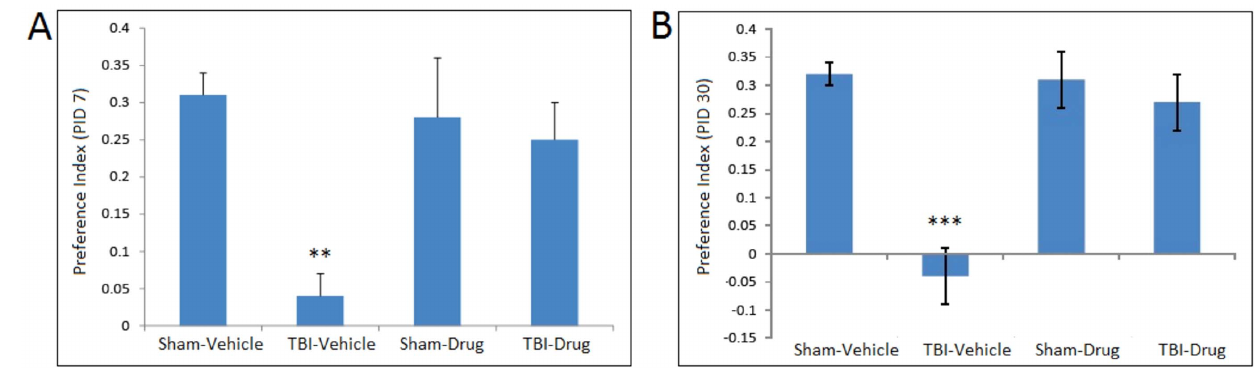
Figure 3. Novel Object Recognition. Preference index for the novel object in the Novel Object Recognition task across post-injury time points. Separate ANOVAs were used to compare the preference index for the novel object during the recall phase of the task. A) Weight drop injury resulted in significant object memory impairment on post-injury day (PID) 7 (A) and PID 30 (B) in injured vehicle-treated mice as compared to all other treatment groups. At both post-injury time points, post-TBI treatment with N-Acetylcysteine + topiramate (Drug) was protective against injury- induced deficits in recognition memory. Animals in the TBI-Drug group performed similarly to Sham-Vehicle and Sham-Drug groups. Values represent the mean 6 SEM . ** p , 0.01, *** p , 0.001 compared to sham vehicle.